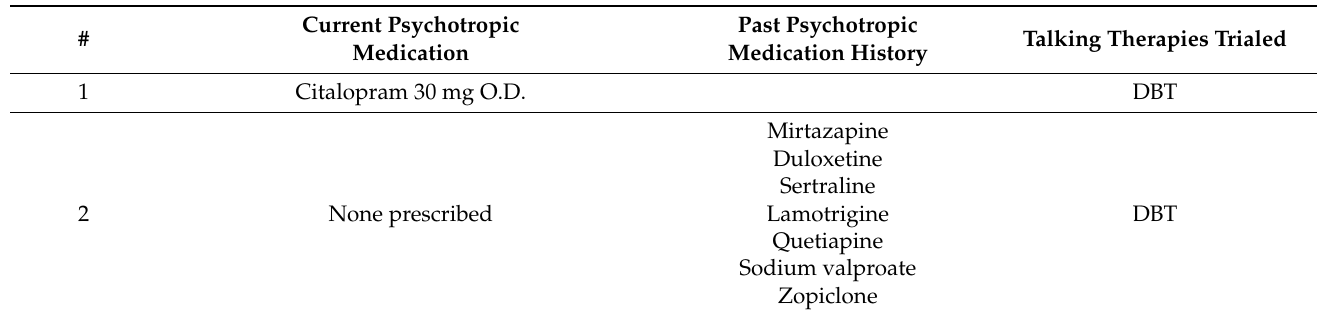
Table 2. Past and present treatment employed for the management of a wide range of symptoms seen in EUPD and other associated